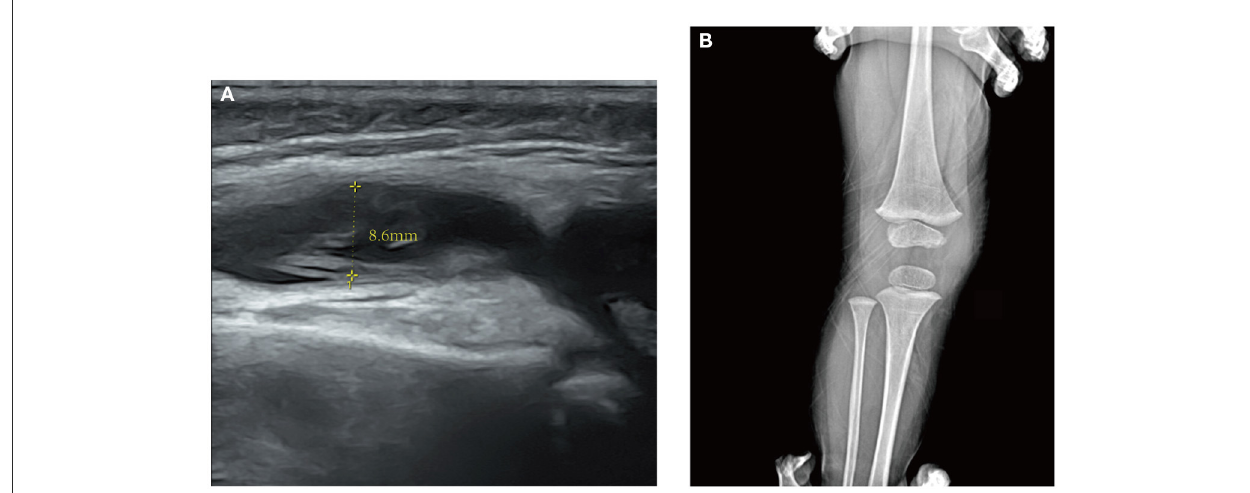
FIGURE2 (A) Ultrasound of the right knee. An anechoic zone with an anteroposterior diameter of 8.6mm is seen in the suprapatellar capsule of the joint suggesting effusion in the suprapatellar bursa. (B) X-ray of the right knee in a half-year follow-up of the patient after discharge. No obvious abnormality is